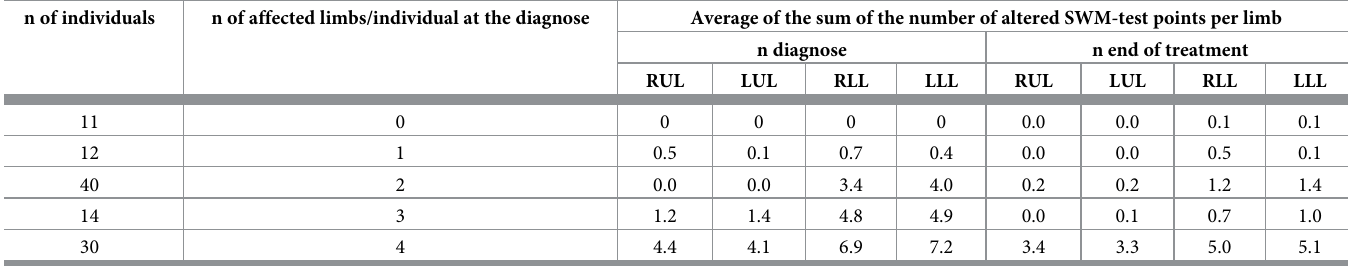
Table 11. Distribution of leprosy patients by number of affected limbs as defined by SWM-test and the respective averages of the sum of the number of altered points per limb and their evolution. n of individuals n of affected limbs/individual at the diagnose Average of the sum of the number of altered SWM-test points per limb n